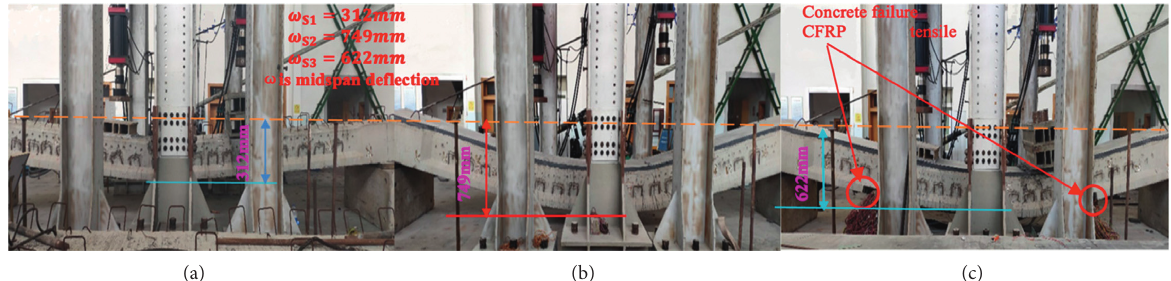
Figure 7: Comparison of maximum deflection of Specimens S1, S2, and S3 in the middle span during testing. (a) Specimen S1. (b) Specimen S2. (c) Specimen S3.